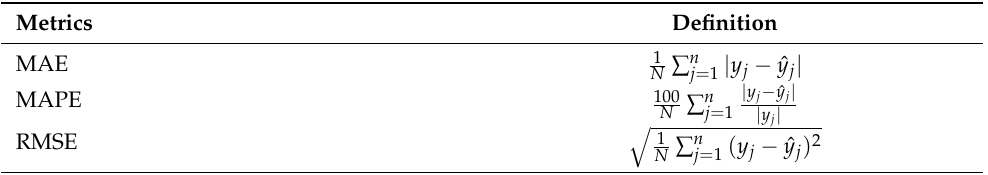
Figure 6. Daily averages of wind speed at selected locations. Table 1. Performance